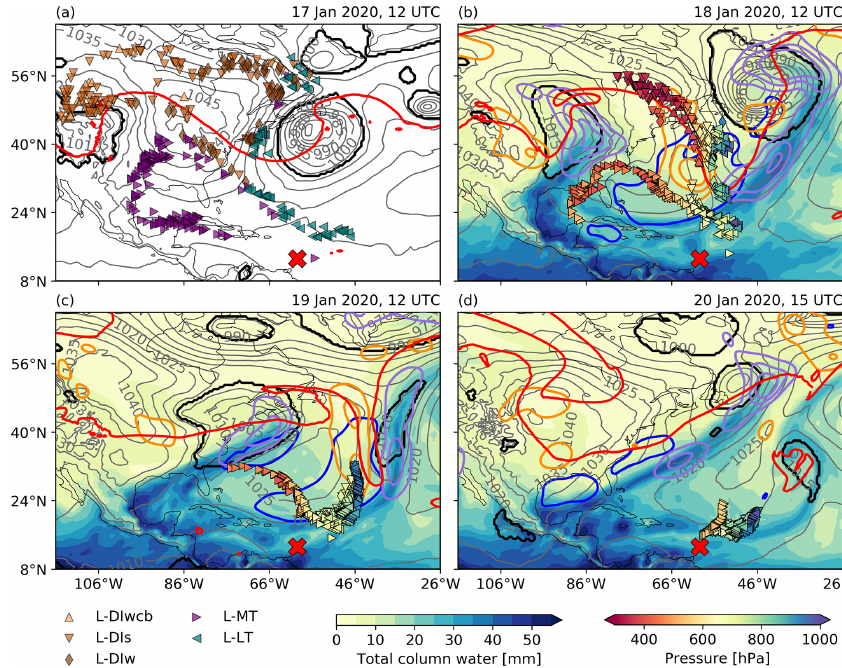
Figure 7. Synoptic situation over the North Atlantic and the position of backward trajectories from the BCO started in the layer 1000– 650hPa on 22 January 2020 (00:00–21:00UTC, every 3h) at (a) 12:00UTC on 17 January, (b) 12:00UTC on 18 January, (c) 12:00UTC on 19 January, and (d) 15:00UTC on 20 January 2020. Trajectory positions are shown as triangles colored according to the (a) airstream or (b–d) pressure. Color shading shows total column water and contours show sea level pressure (gray; 5hPa intervals), cyclone masks (black), surface evaporation (blue; intervals of 0.5mmh − 1 ), upward and downward winds at 500hPa (purple and orange, respectively; ± 0.2, ± 0.4, ± 0.6Pas − 1 ), and 2pvu at 320K (red). The red cross marks the location of Barbados. A Gaussian filter was applied to surface evaporation and vertical winds for better readability. Data: ERA5. Table 3. Pearson correlation coefficient matrix for the daily mean IWV 1000–650hPa , the daily precipitation totals, the daily mean CRE, and the daily mean divergence at 950hPa at the BCO for the 44 EDI (608 non-EDI) days of the quasi-climatological period. Data: ERA5. Precipitation CRE Divergence [mm] [Wm − 2 ] [10 − 6 s − 1 ] IWV 1000–650hPa [mm] 0.71 (0.53) − 0.22 ( − 0.28) − 0.66 ( − 0.52) Precipitation [mm] − 0.35 ( − 0.28) − 0.84 ( − 0.43) CRE [Wm − 2 ] 0.37